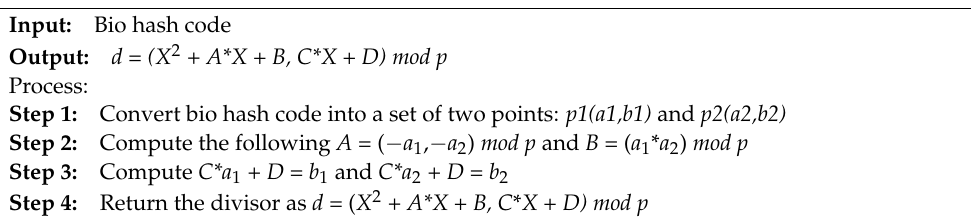
Algorithm 2 : Bio Hash Code Converted into Divisors